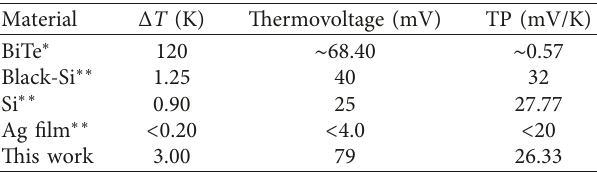
Table 1: Comparison of thermoelectric properties of usual/nano